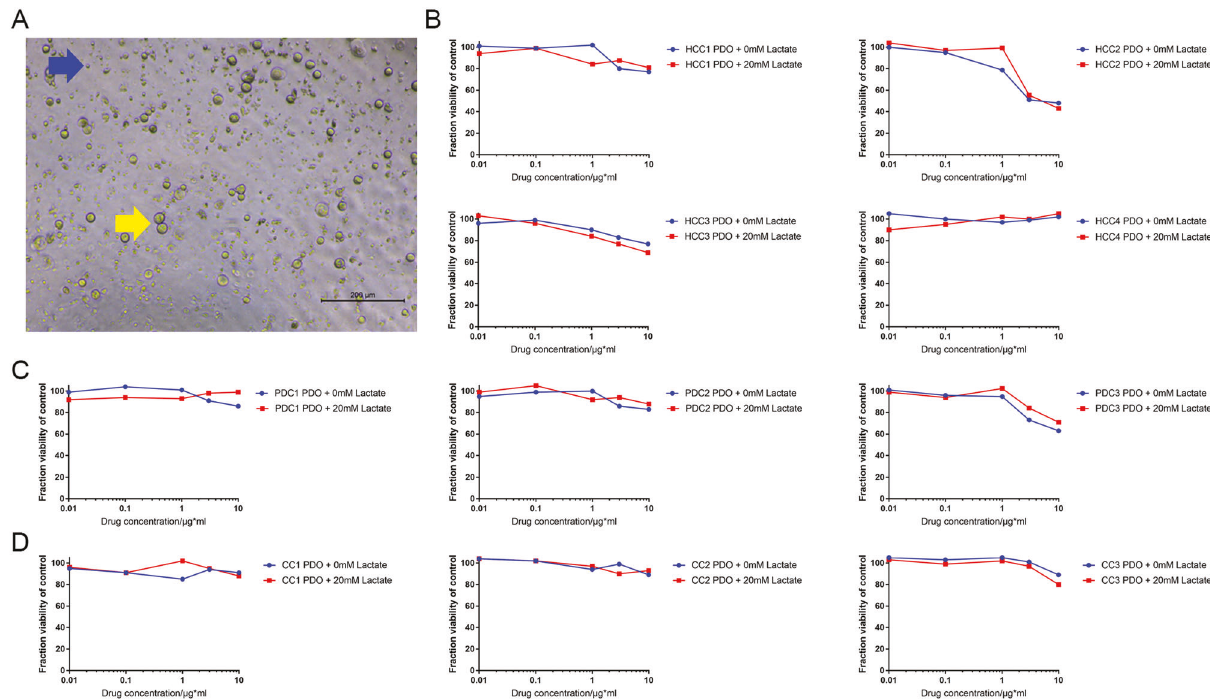
Fig. 6 Lactate retained the sensitivity of the PDOs to immune checkpoint inhibitors. A Representative images of co-cultured CC2 PDO and PBMCs. Blue arrow indicates PMBC and yellow arrow indicates CC2 PDO. B Dose – response curves of ten PDOs of four HCCs without or with 20 mM lactate treatment to tislelizumab. C Dose – response curves of ten PDOs of three PDCs without or with 20 mM lactate treatment to tislelizumab. D Dose – response curves of ten PDOs of three CCs without or with 20 mM lactate treatment to